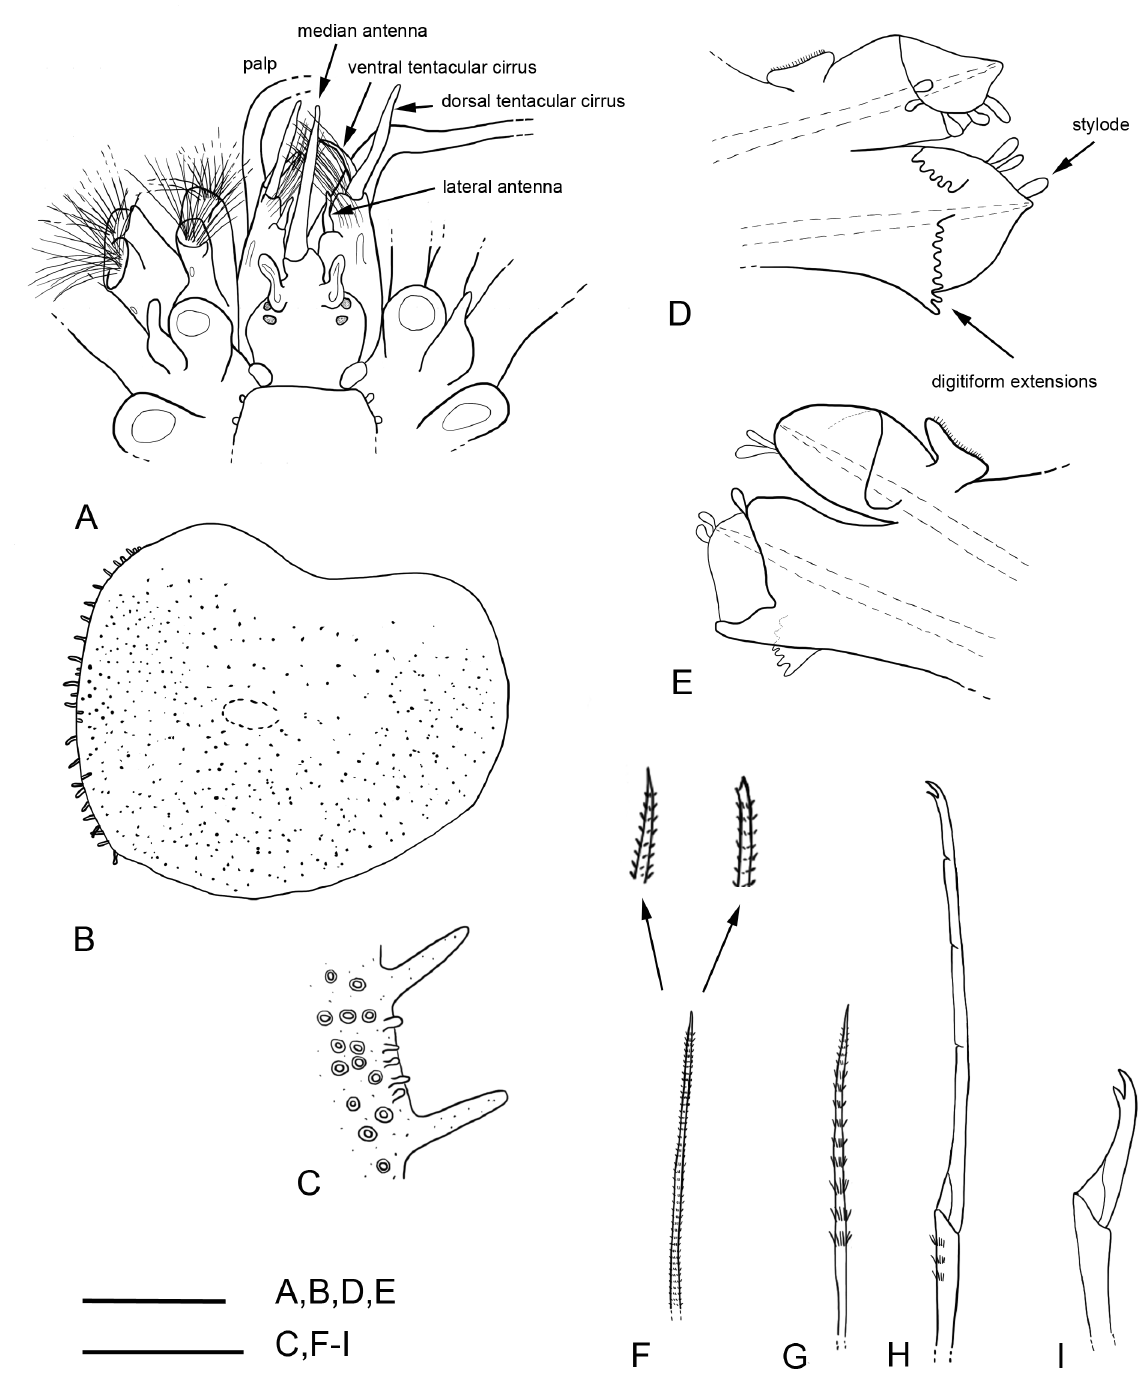
Fig. 4. Sthenelais boa (Johnston, 1833). TUM 39683 (A–B, D–E) and SMF 10629 (C, F–I). A . Anterior end. B . Left elytron of segment 21. C . Detail of outer lateral elytral margin. D . Left parapodium of segment 21, anterior view. E . Same, posterior view. F . Capillary notochaeta, with details of simple or bidentate tip (not to scale). G–I .Neurochaetae of segment 19, all distal part. G . Upper simple, spinous neurochaeta. H . Upper slender compound falciger. I . Middle stout compound falciger. Scale bars: A–B = 1 mm; D–E = 250 µm; C, F–I = 100